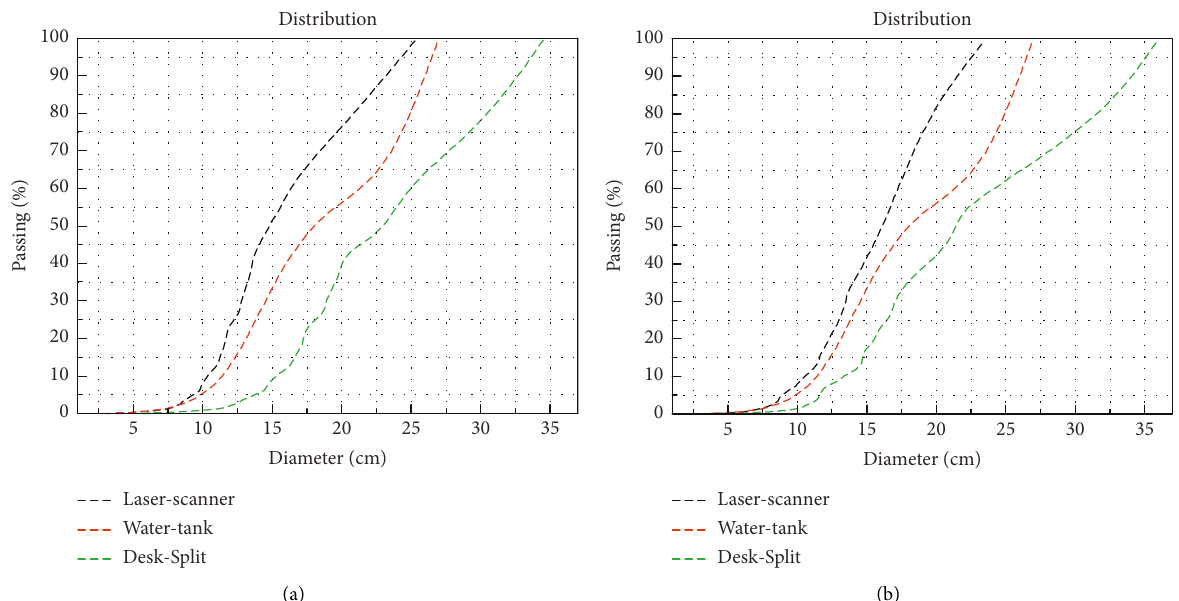
Figure 11: Size distribution of the stacked blocks including the information on the surface blocks. (a) Case 1. (b) Case 2.